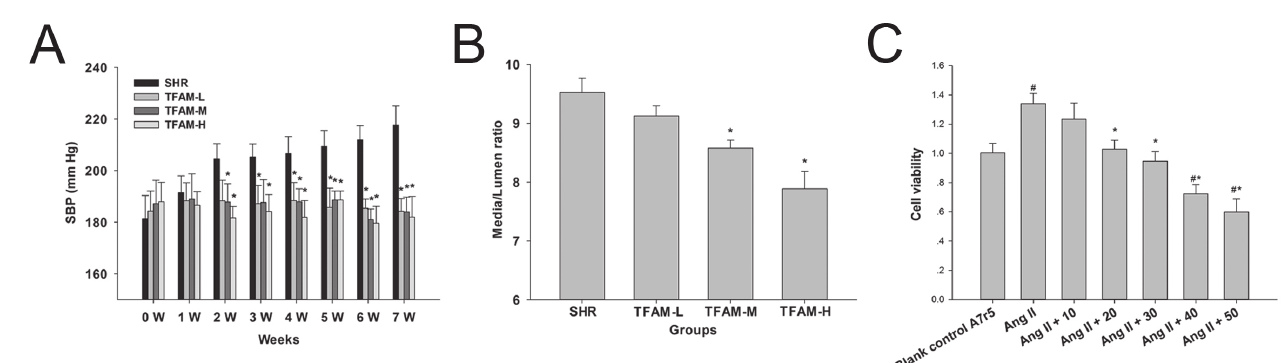
FIGURE 1 - TFAM ameliorated the hemodynamic and physical parameters in spontaneously hypertensive rats, and suppressed Ang II-induced A7r5 cell proliferation in Vitro . (A) TFAM restored the systolic blood pressure in SHRs. SBP (mmHg) values from untreated SHRs or those treated with TFAM (TFAM-L, 90 mg/kg; TFAM-M 180 mg/kg; TFAM-H, 360 mg/kg) were recorded during light and dark cycles each week. Summary graphs to demonstrate the effects of TFAM on SBP. * indicates P < 0.01 compared to the SHR group. (B) TFAM attenuated the rate of media thickness versus lumen diameter. The media thickness of the thoracic aorta and lumen diameter were obtained in histologic sections, respectively. Data represented as mean ± SD from n = 6 rats per treatment group in (A) and (B) , the values given are the mean ± SD of three independent experiments. *P < 0.05 compared with the control SHR group. (C) CCK-8 assay was employed to evaluate the effects of TFAM on Ang II-induced A7r5 cell proliferation. A7r5 cells were treated with 10-50 μg/mL for 24 h. Cell viability was normalized to black control group. The values given are the mean ± SD of five independent experiments. * P <0.05 compared to Ang II group. # P <0.05 compared to blank control